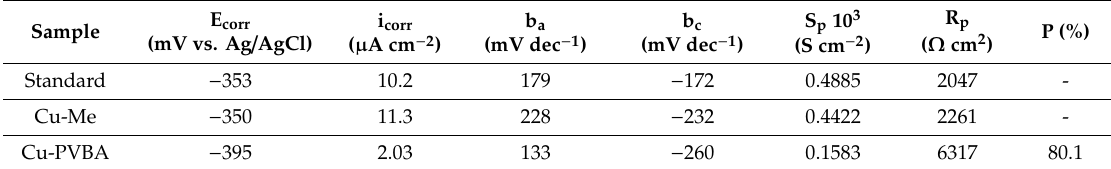
Table 2. The electrochemical parameters calculated from potentiodynamic measurements for standard Cu, methanol-treated Cu, and PVBA modified Cu, in 0.9% NaCl solution, at room temperature.